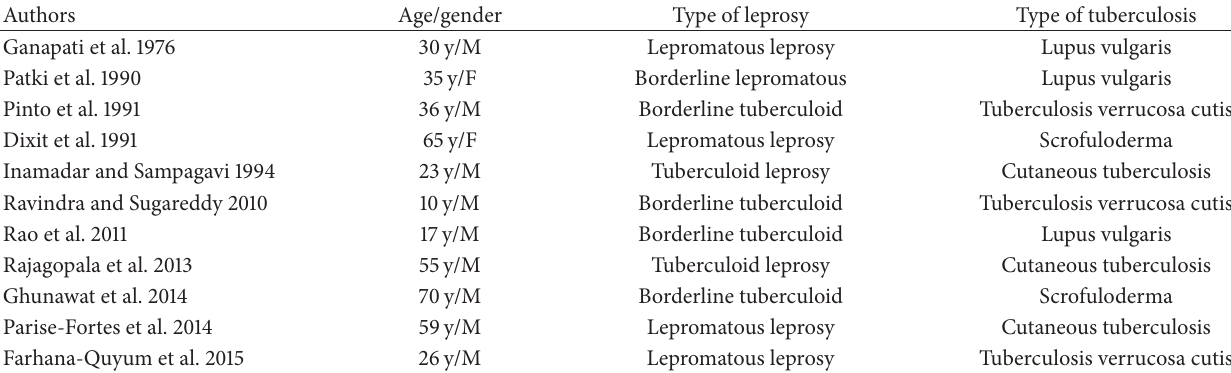
Table 1: Cases of coexistence of leprosy with cutaneous tuberculosis reported in